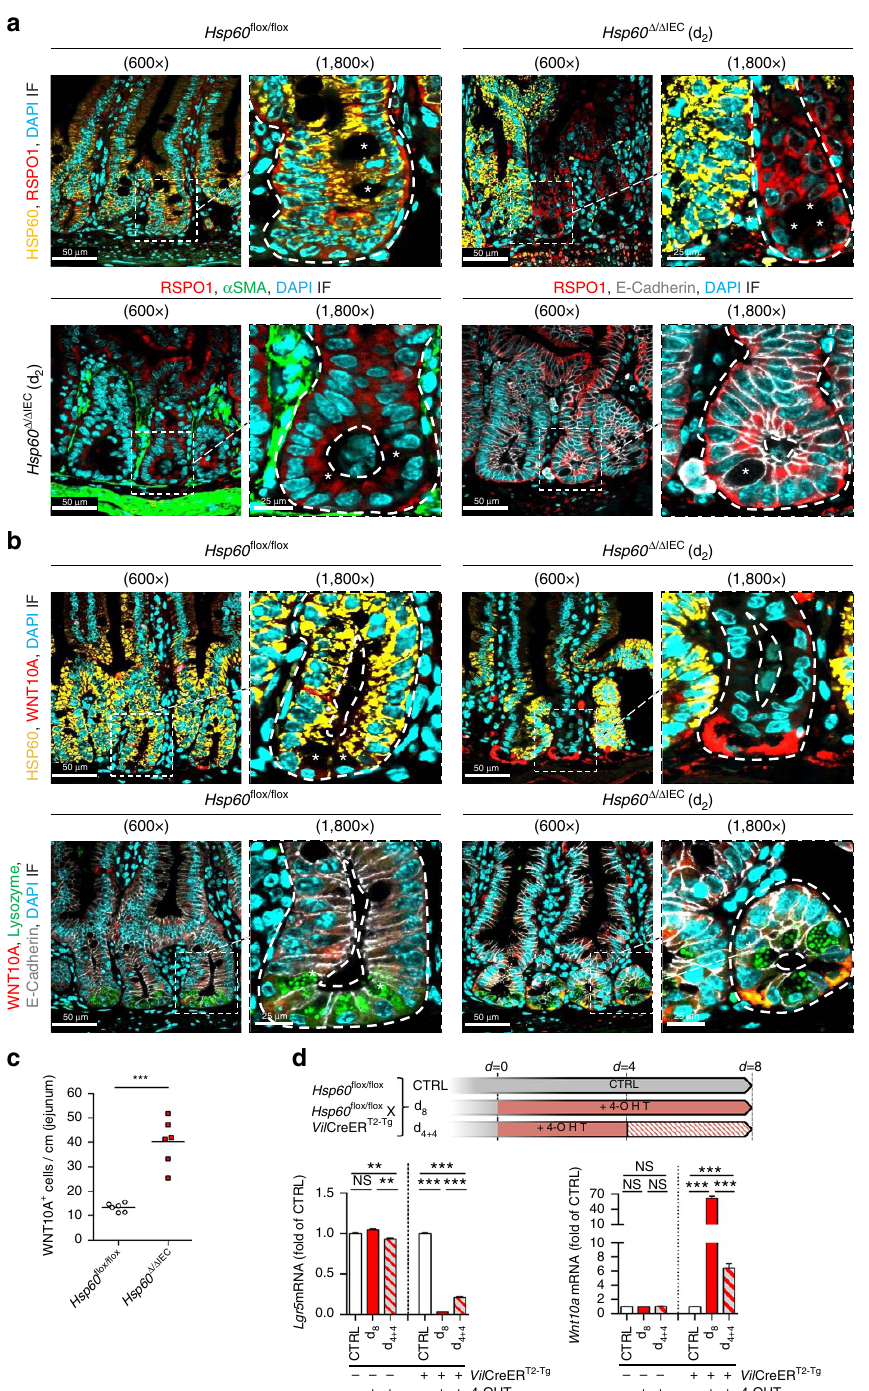
Figure 8 | HSP60 loss is associated with epithelial induction of WNT-related signals. ( a ) IF images show epithelial RSPO1 (red) and HSP60 (yellow) expression at d 2 in jejunal sections from Hsp60 D / D IEC and Hsp60 flox /flox mice. E-Cadherin (grey) and a SMA (green) were used as epithelial and mesenchymal cell marker, respectively (DAPI stains nuclei in cyan, asterisks indicate Paneth cells). ( b ) IF images show epithelial WNT10A (red) and HSP60 (yellow) expression at d 2 in jejunal sections from Hsp60 D / D IEC and Hsp60 flox /flox mice. Lysozyme (green) and E-Cadherin (grey) were used as Paneth cell and epithelial cell marker, respectively (DAPI stains nuclei in cyan). WNT10A and Lysozyme co-stained (yellow, lower panel). ( c ) Quantification of WNT10A-positive cells in the jejunum of Hsp60 D / D IEC and Hsp60 flox /flox mice ( N ¼ 6). Lines in the dot plot indicate mean numbers. Statistical analysis was performed using unpaired t -test. ( d ) Experimental scheme to induce Hsp60 loss in small intestinal organoids. qRT–PCR analysis of Lgr5 and Wnt10a mRNA expression in organoids following gene knockout. Data from organoid experiments derive from at least 3 independent experiments. Bars represent mean þ s.e.m. One-way analysis of variance and appropriate post-hoc tests were used for statistical analysis. Asterisks in c , d indicate significant differences * P o 0.05, ** P o 0.01, *** P o 0.001; NS, not significant.